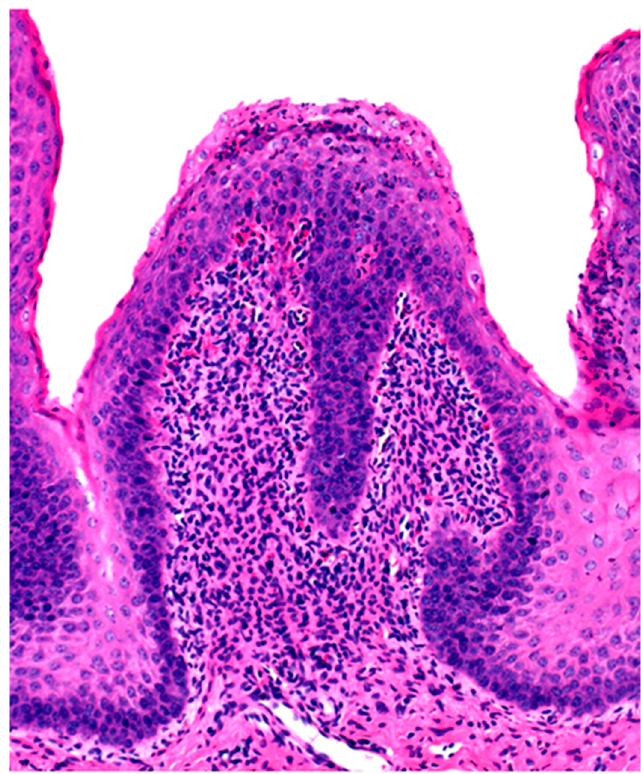
Figure 2. Ruminal papilla with intraepithelial ne trophilic aggregates and pleocellular inflammation in the lamina propria.